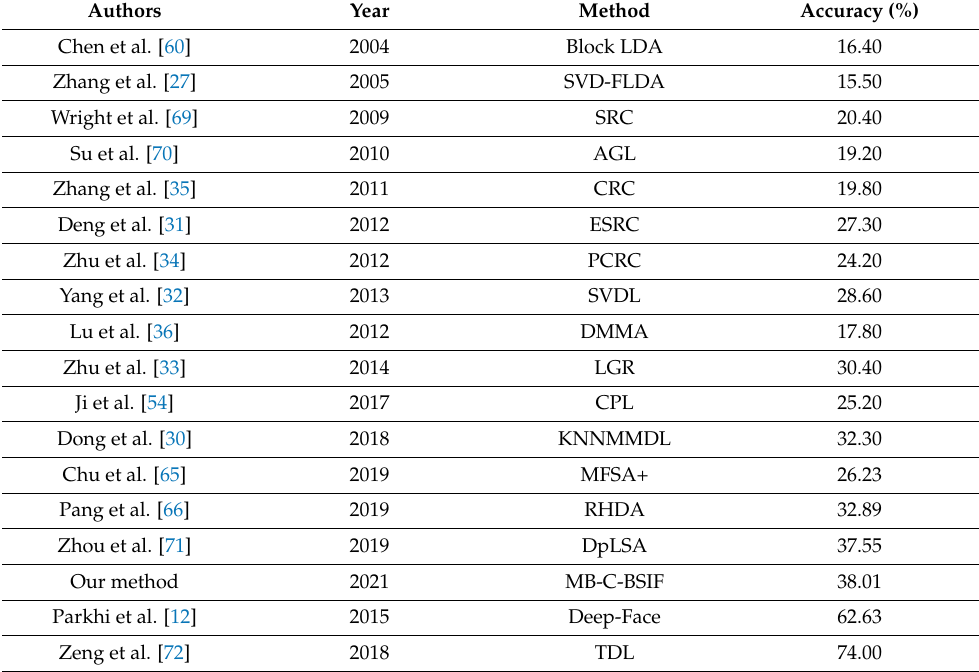
Table 15. Identification accuracies using the LFW